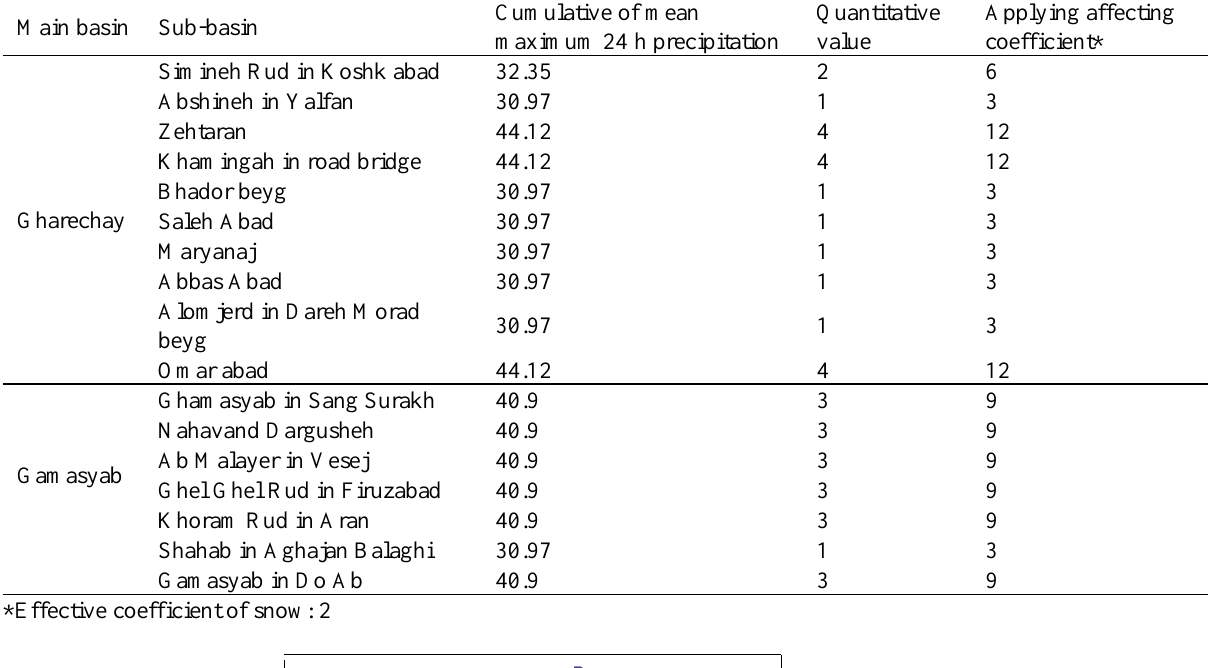
Quantitative Applying affecting value coefficient*